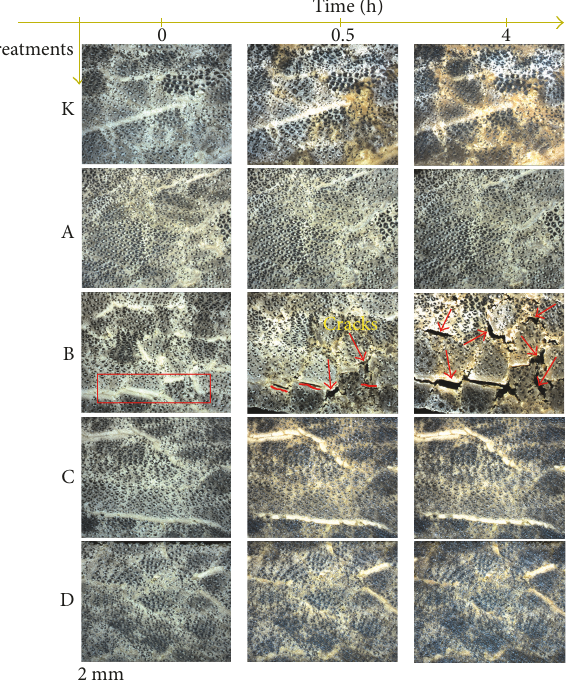
Figure 6: Representative optical images of the cross-section of bamboo scrimbers during the 4-hour treatments of K, A, B, C, and